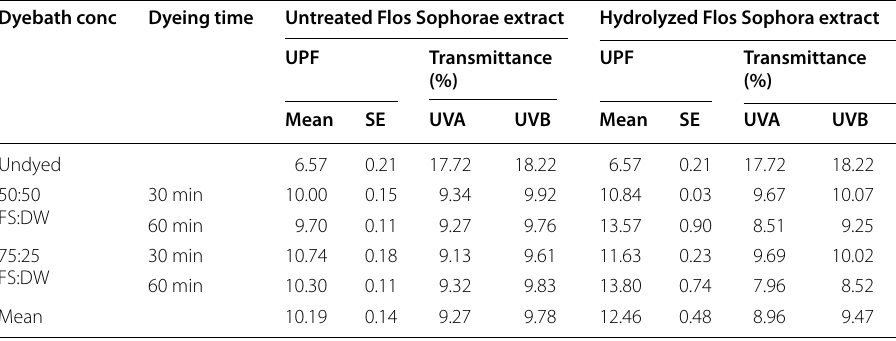
Table 10 UV protection values of cotton dyed with untreated and hydrolyzed extract of Flos Sophorae Dyebath conc Dyeing time Untreated Flos Sophorae extract Hydrolyzed Flos Sophora extract UPF